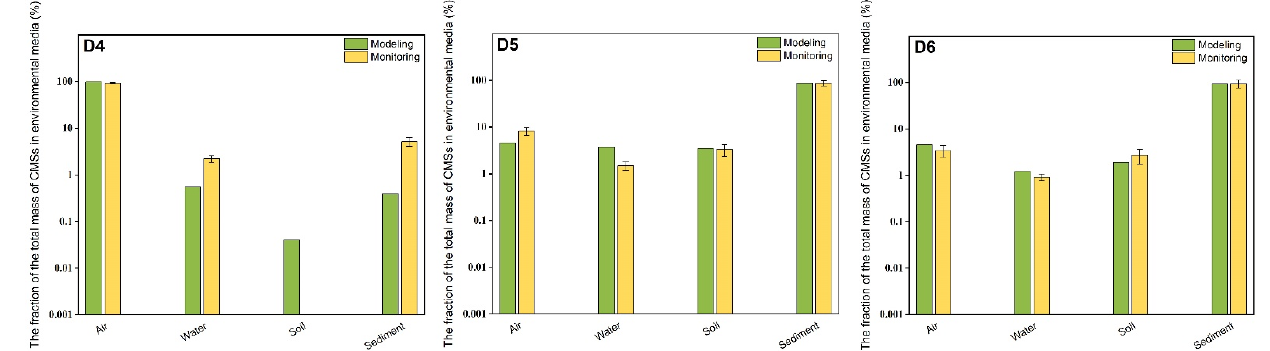
Figure 1. The actual value (%) and simulated value (%) of the fraction of the total mass of CMSs (D4–D6) in each environmental media in Beijing.